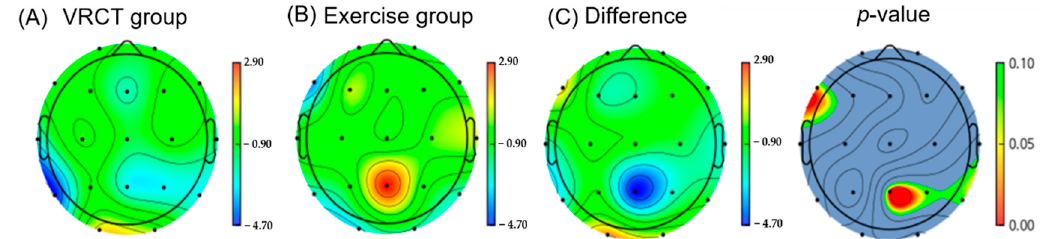
Figure 2. This shows the difference in Theta band power in the VRCT group compared to the exercise group at follow-up. (The color bars ( A – C ) indicate power density: blue indicates lower power density and red indicates higher power density. The color bar next to p -value indicates the p value ranging from 0.10 (green) to 0.00 (red).